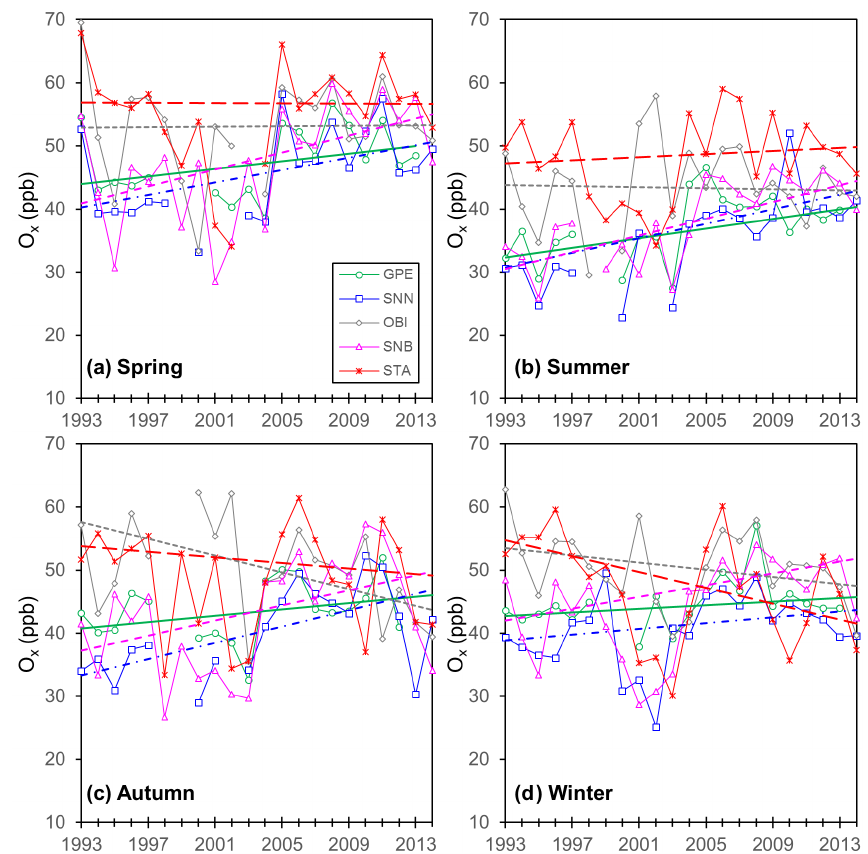
Figure 7. Seasonal trends in O x within the MMA during 1993–2014. Each data point represents the average of the 3-month period that defines the season. The continuous lines show the Sen